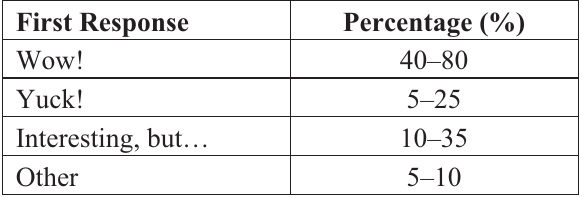
Table 1. First responses to the idea of cultured